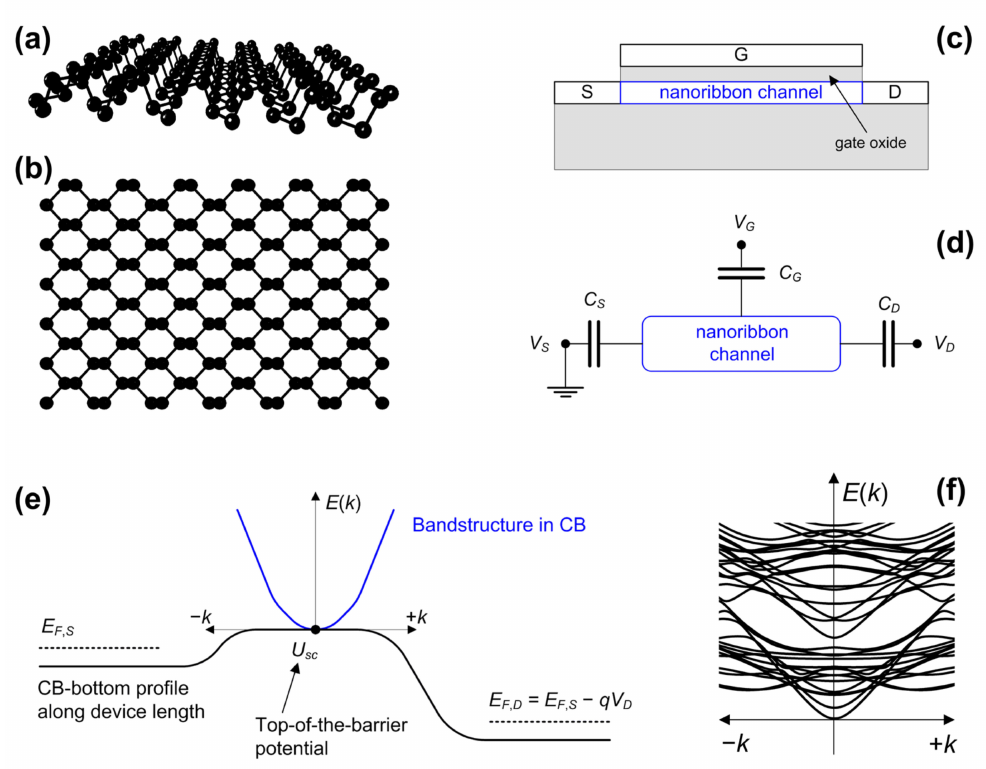
Figure 1. Illustration of a phosphorene nanoribbon with ( a ) side and ( b ) top view, as well as of ( c ) PNR FET cross-sectional view. ToB model description with ( d ) capacitive model, ( e ) bandstructure along the channel length, and ( f ) example of a PNR bandstructure calculated by the DFT-TB